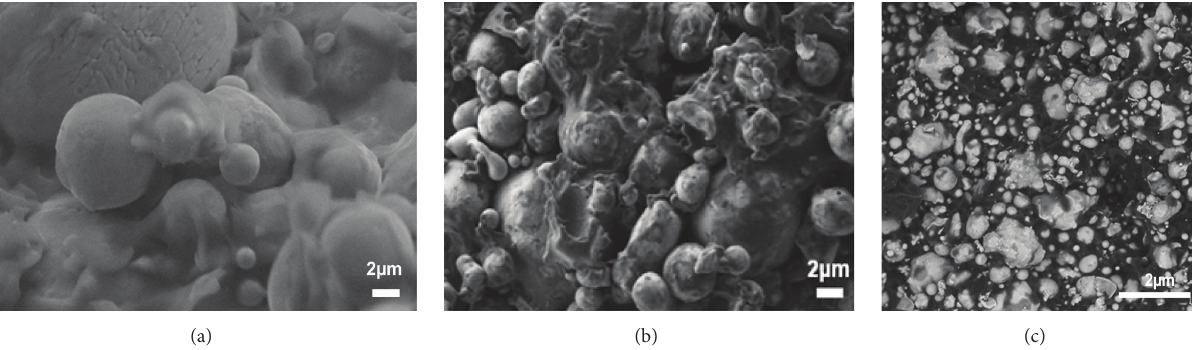
Figure 3: SEM micrographs of feedstocks for (a) PGA powders, (b) P25/75 mixture powders, and (c) PWA- 𝑛 B mixture